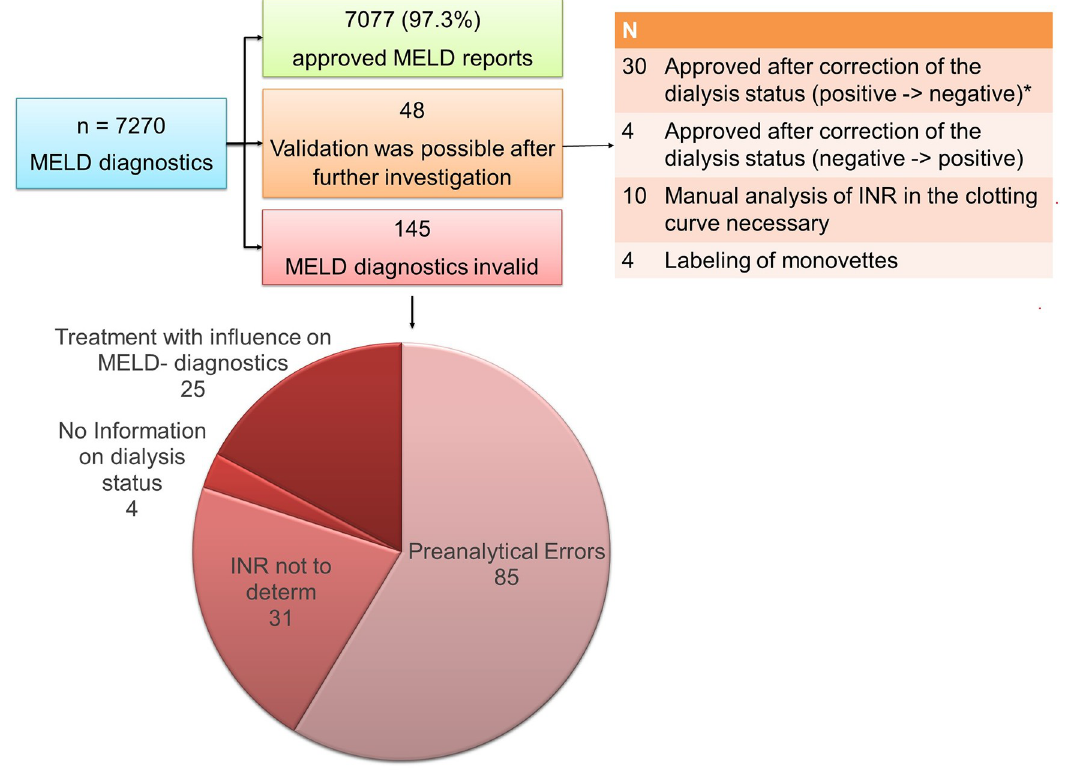
Fig 2. Summary of the requested MELD scores and the results of the laboratory medical validation. Anticoagulation might be indicated within patients with liver diseases. However, INR must be unchanged for valid MELD- diagnostics. In 25 cases, treatment with anticoagulation had influence on the INR and consequently on the MELD score. Therefore, a validation was not possible. � Dialysis status or interval did not fulfill the official criteria. However, no cases of deliberate misreporting were